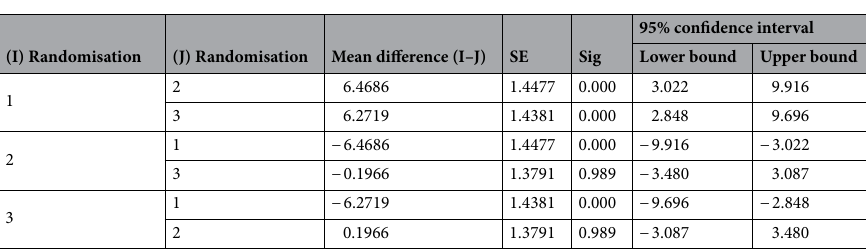
Table 6. Comparison between groups of Time required to achieve first GMAWS = 0 score (one-way ANOVA Tukey test).